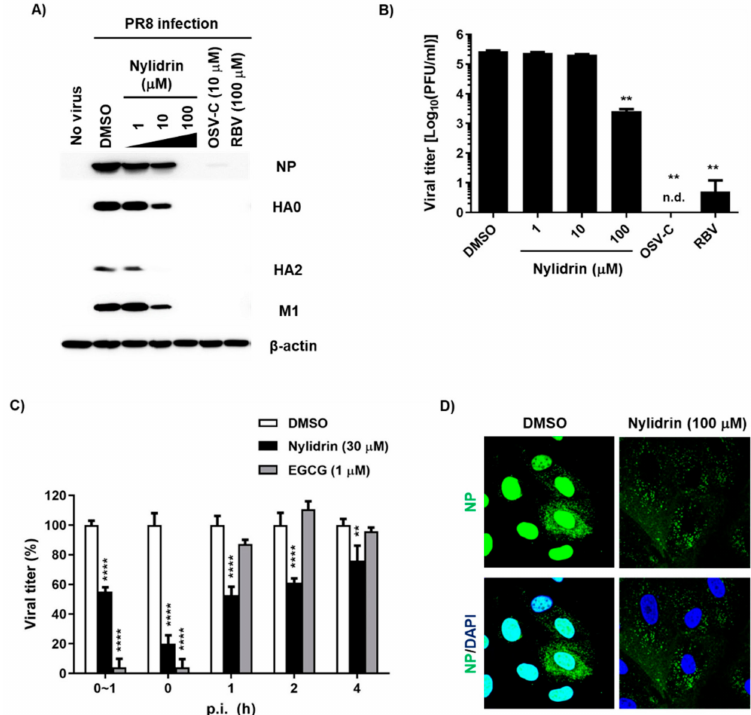
Figure 2. Inhibition of influenza virus infection by nylidrin. ( A ) Western blot analysis showing the dose-dependent decrease in viral proteins by nylidrin. Madin-Darby canine kidney (MDCK) cells were mock-infected (no virus) or infected for 24 h with the PR8 virus at a multiplicity of infection (MOI) of 0.001 in the presence of dimethyl sulfoxide (DMSO; 0.2%, a delivery vehicle), nylidrin (1, 10 or 100 µ M), oseltamivir carboxylate (OSV-C; 10 µ M), or ribavirin (RBV; 100 µ M). Each viral protein and α -actin, as a loading control, are marked on the right side of the gels. ( B ) Plaque reduction assay. Viral titers were determined using culture supernatants from the same samples as in (A). This represents one of the three independent experiments. Statistical comparisons were performed using a two-tailed unpaired t -test. n = 2; **, p < 0.01. n.d., not detected. ( C ) Time-of-addition experiment. Nylidrin or ( − )-epigallocatechin gallate (EGCG; an entry blocker) was administered during virus adsorption at 4 ◦ C for 1 h (0~1 h) or at the indicated time points post-infection (p.i.) (0, 1, 2, and 4 h). At 5 h p.i., the supernatants were removed and replaced with an overlay medium for incubation at 35 ◦ C. The percentage plaque number was determined by crystal violet staining on day 3. This represents one of the three independent experiments. Statistical significance was assessed using a two-way ANOVA with Dunnett’s multiple comparisons tests. n = 2; **, p < 0.01; ****, p < 0.0001. ( D ) Confocal microscopy. MDCK cells were infected with PR8 (MOI, 1) at 37 ◦ C for 5 h in the presence of DMSO (delivery vehicle) or nylidrin (100 µ M). Viral NP (green) and cellular nuclei (blue) were detected using NP-specific antibody and DAPI, respectively. Original magnification, 400 ×